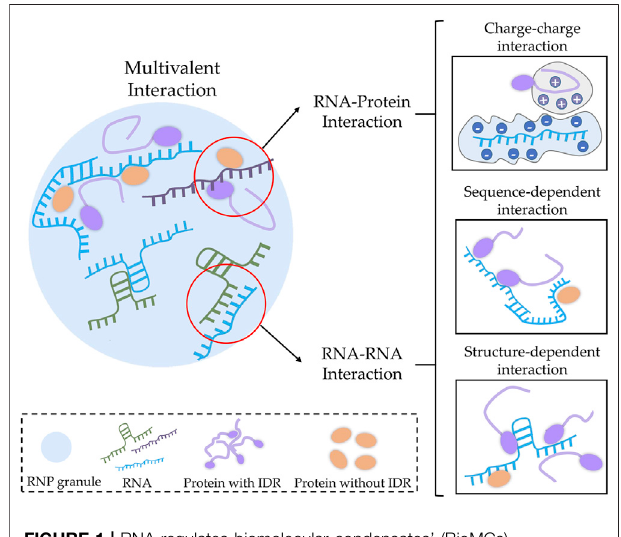
FIGURE 1 | RNA regulates biomolecular condensates ’ (BioMCs) properties through providing multivalence. RNA acts as an important multivalence provider through interacting with other bio-macromolecules (such as proteins and RNA) via charge – charge, sequence-speci fi c, and structure-dependent